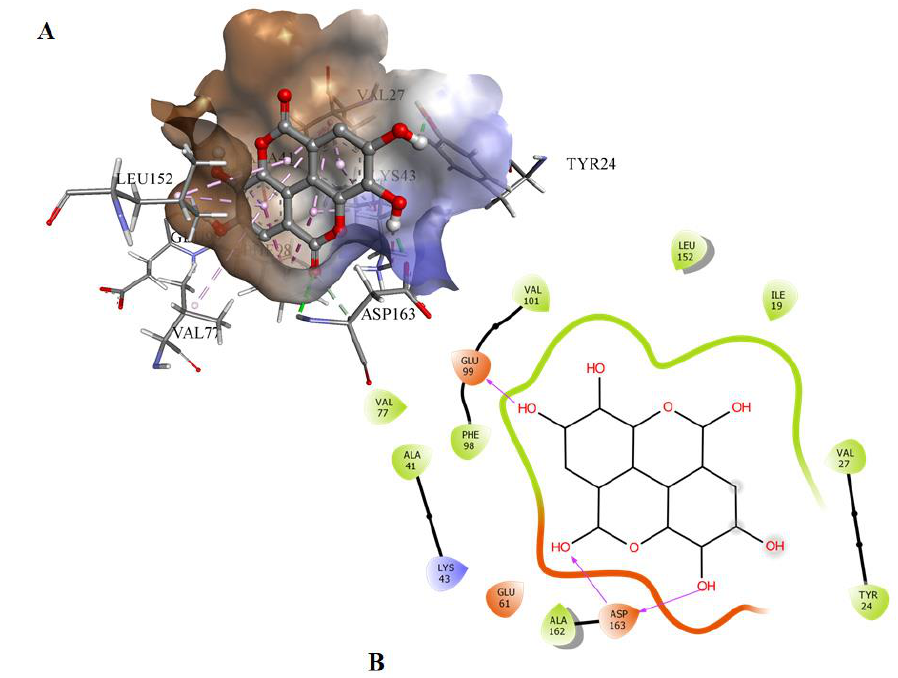
Figure 1. ( A ) The docked conformation of EA and CDK6 in the 3-D view showing the bound orientation of the inhibitor. ( B ) The 2-D view of the docked complexes highlighting the observed hydrogen bonds between the inhibitor and protein